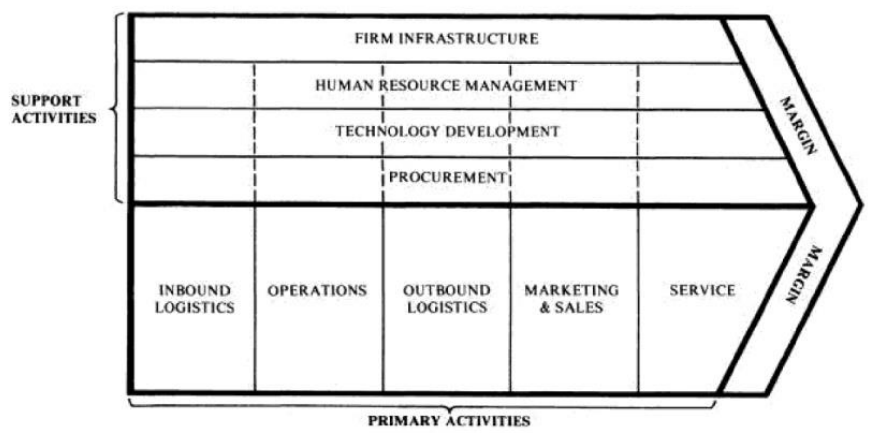
Figure 1. The generic value chain model. Source: (Porter 1985).